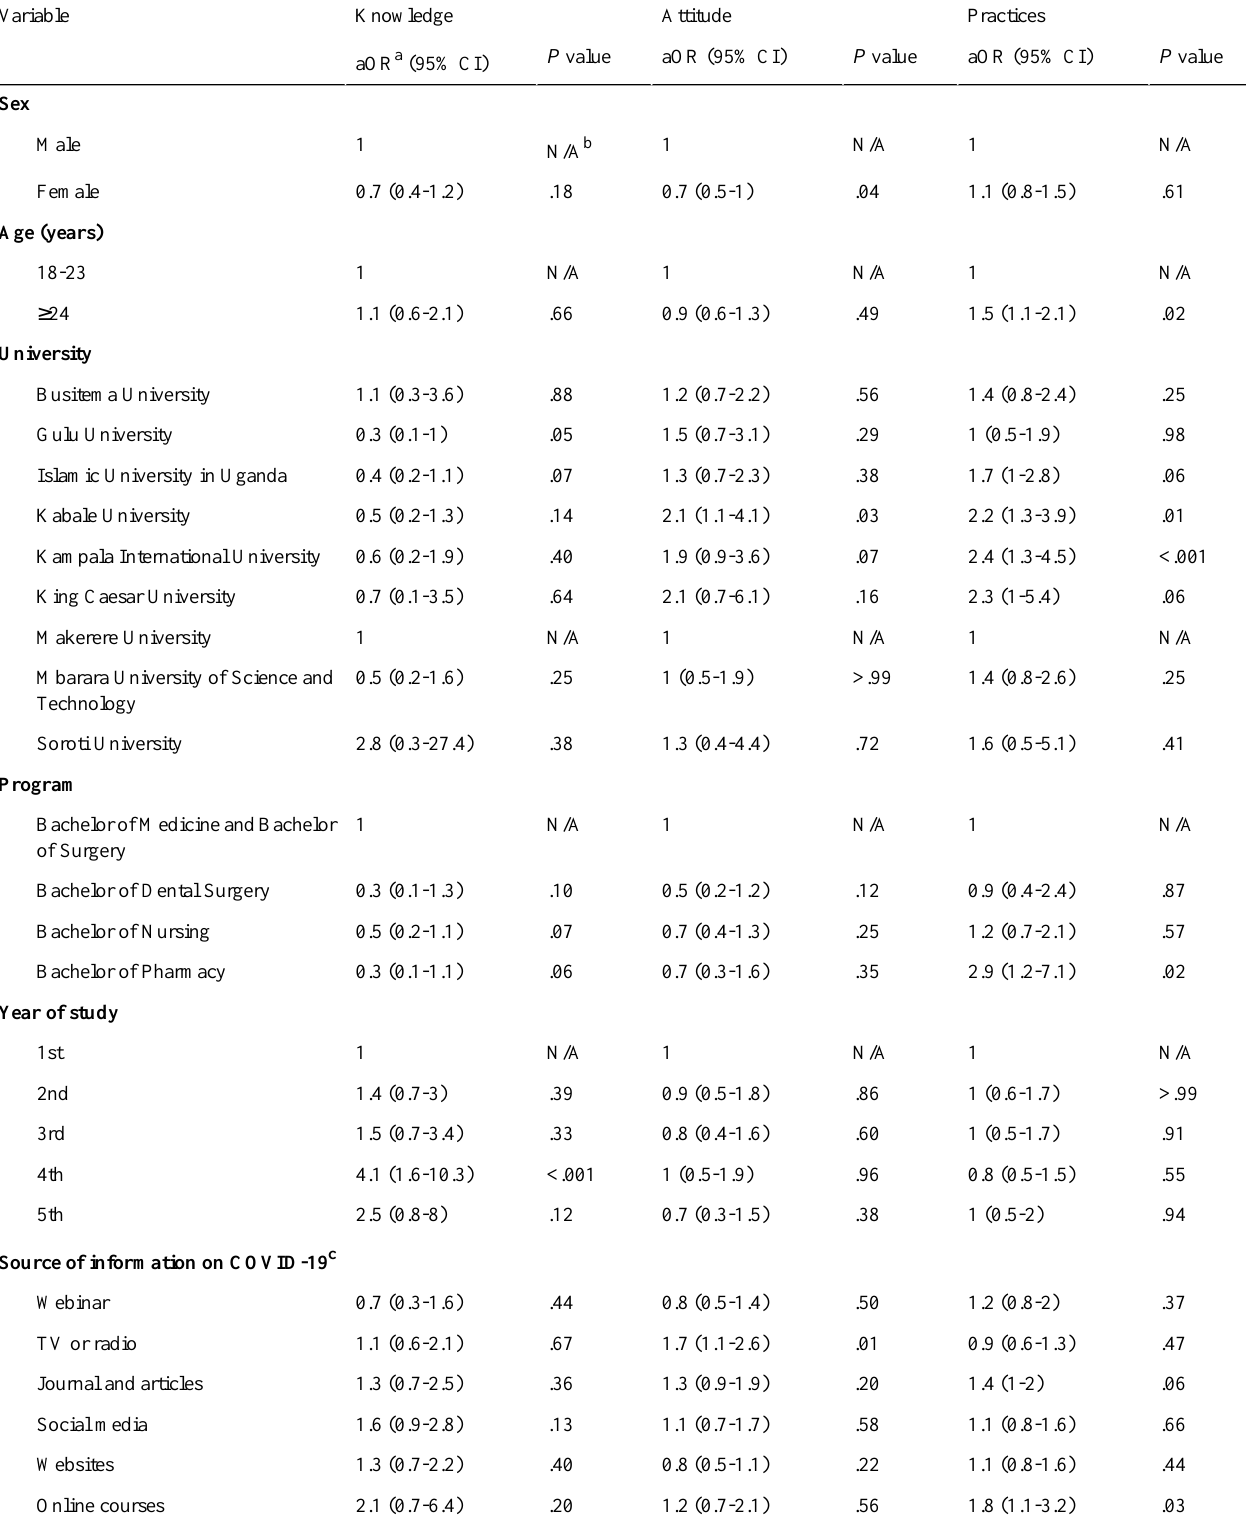
Table 4. Multivariate analysis showing factors associated with knowledge, attitude, and practices toward COVID-19 among Ugandan medical students.